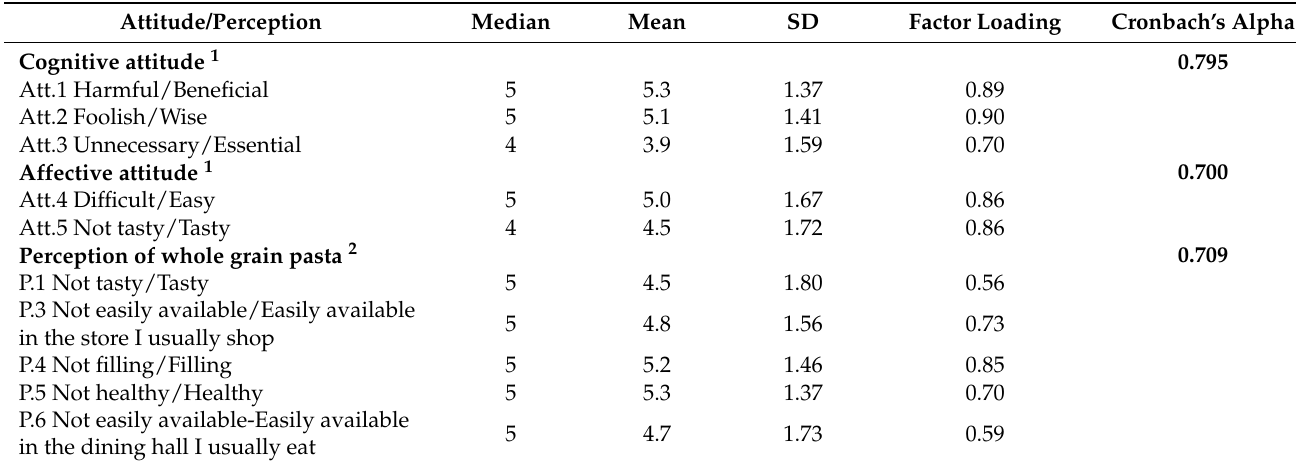
Table A3. Factor analysis results of attitude of including wholegrain pasta in the diet over the next month and perception of wholegrain